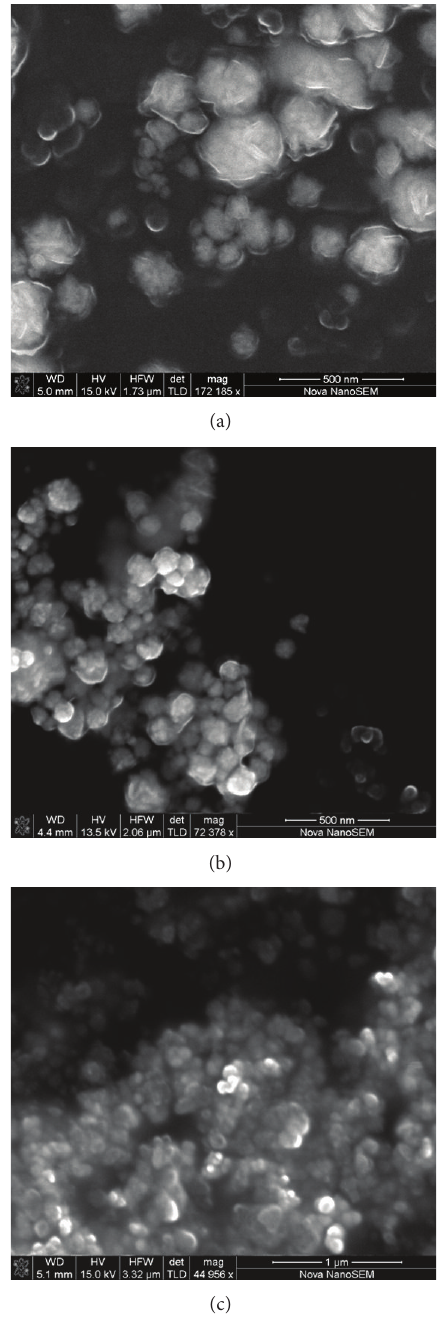
Figure 5: SEM images of (a) nickel, (b) Ni-PVP, and (c) Ni(OH) 2 powder